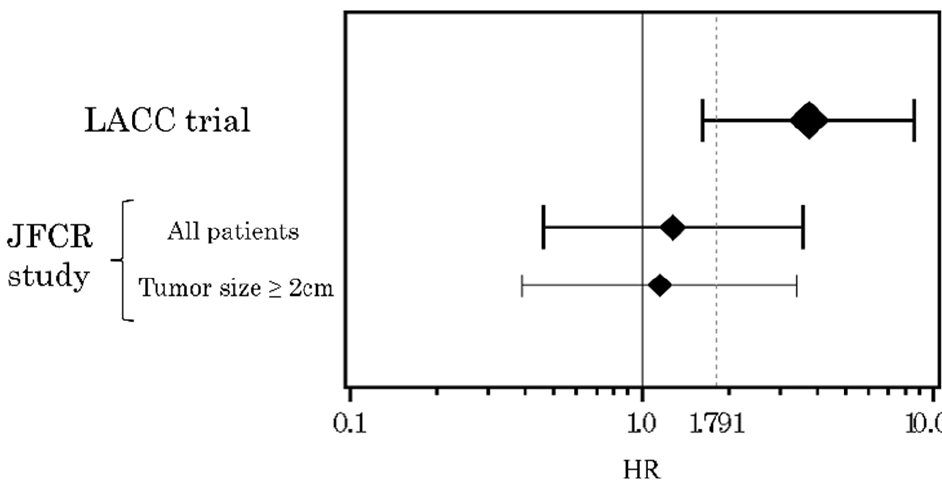
Figure 3. Comparison of heterogeneity between patients in the LACC trial and those in our study; hazard ratios with 95% confidence intervals for relapse among patients who underwent minimally invasive surgery (compared with patients who underwent open surgery). The size of the diamond is proportional to the inverse of the square of the standard error. The vertical dotted line is equivalent to the non-inferiority margin used in the LACC trial converted to the hazard ratio, which has a value of 1.791. The hazard ratio in patients with tumor size < 2 cm in diameter could not be calculated because no relapses occurred among patients in the ARH group. LACC—Laparoscopic Approach to Cervical Cancer (trial); JFCR—Japanese Foundation for Cancer Research; NLNT—laparoscopic radical hysterectomy using the no-look no-touch technique; HR—hazard